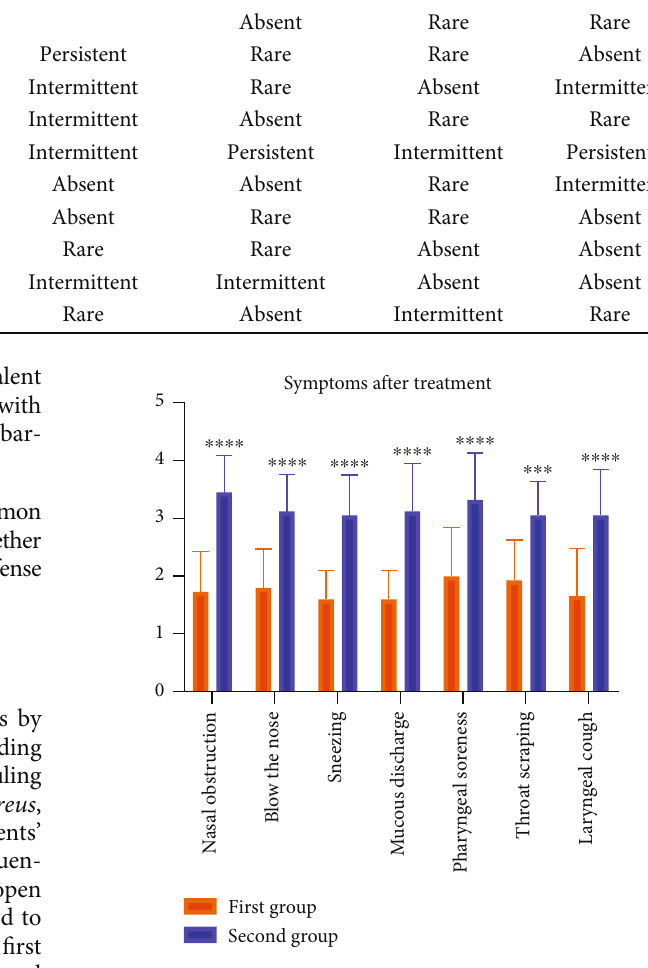
Figure 1: Graphical representation of symptoms in fi rst and second group after treatment. There were signi fi cant di ff erences. ∗∗∗∗ P < 0 : 0001 fi rst- vs. second group.